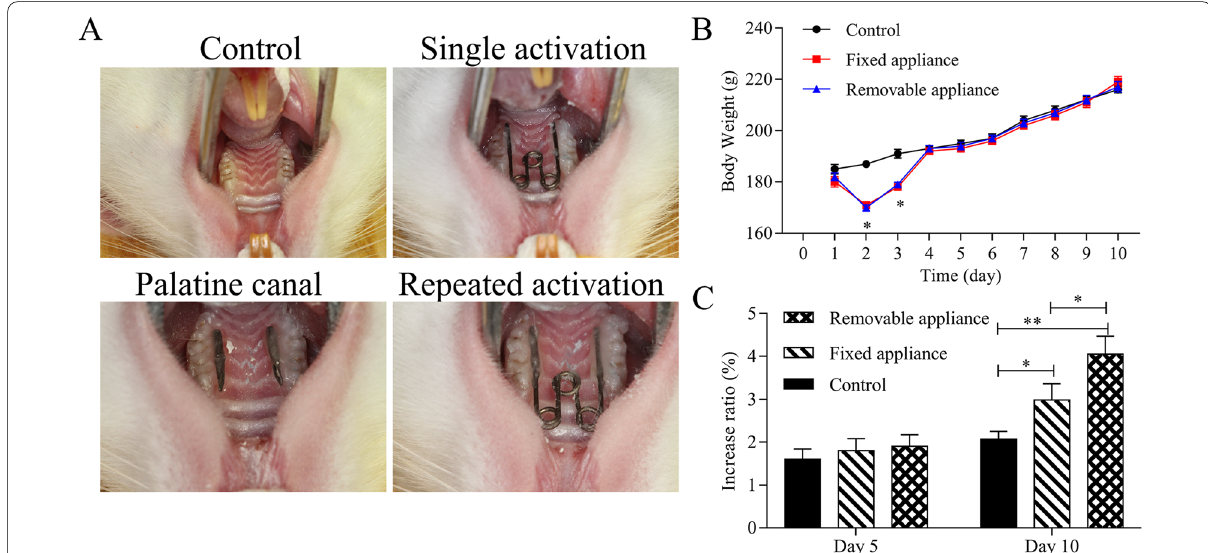
Fig. 1 The changes of body weights and maxillary arch widths of maxillary expansion model rats. A Establishment of maxillary expansion model rats with continuous force. B The body weights of rats were measured after maxillary expansion. C The maxillary arch widths of rats were examined after maxillary expansion, and the increase ratio was counted. * P < 0.05, ** P < 0.01 versus control